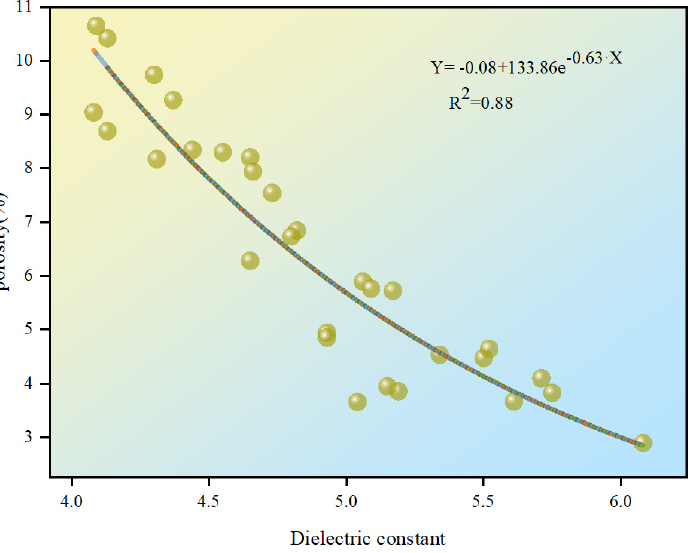
Figure 8. Fitting of the representative values of the dielectric constant obtained by Method 2 and the porosity.